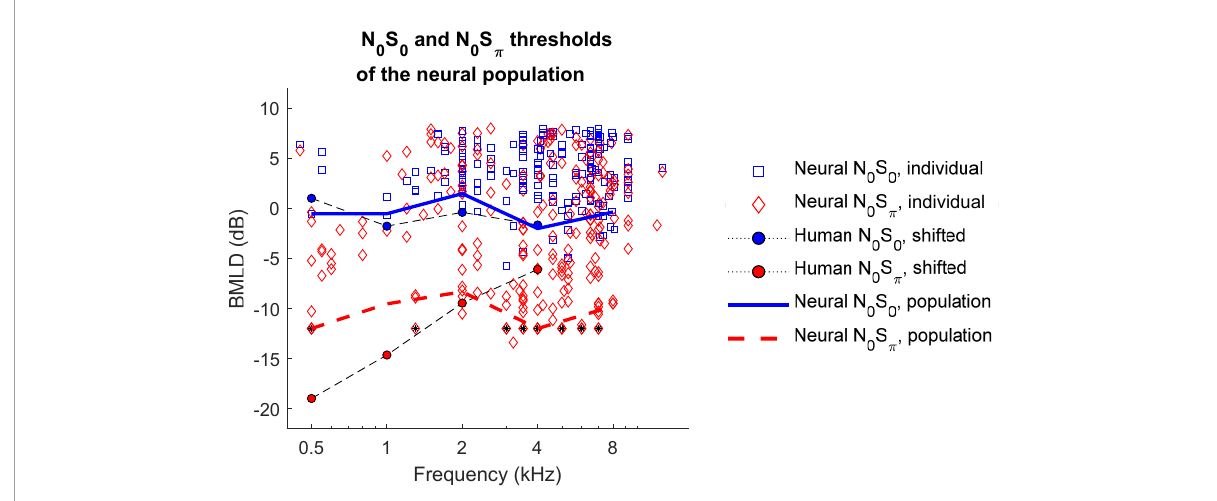
FIGURE9 N 0 S 0 (solid blue line) and N 0 S π thresholds (dashed red line) of the neural population across frequency. Individual neural thresholds at 79.1% correct for N 0 S 0 (blue square) and N 0 S π (red diamond) conditions, for noise levels of 55–75 dB SPL are shown for all neurons with measurable thresholds above the lowest SNR tested. Symbols with a black star indicate that the threshold was lower than the lowest measured SNR. Human detection thresholds are from van de Par and Kohlrausch (1999) and shifted up by 4 dB for comparison with neural thresholds, which were computed using a higher criterion. Neural binaural masking level differences (BMLDs) had a different trend across frequency compare to human